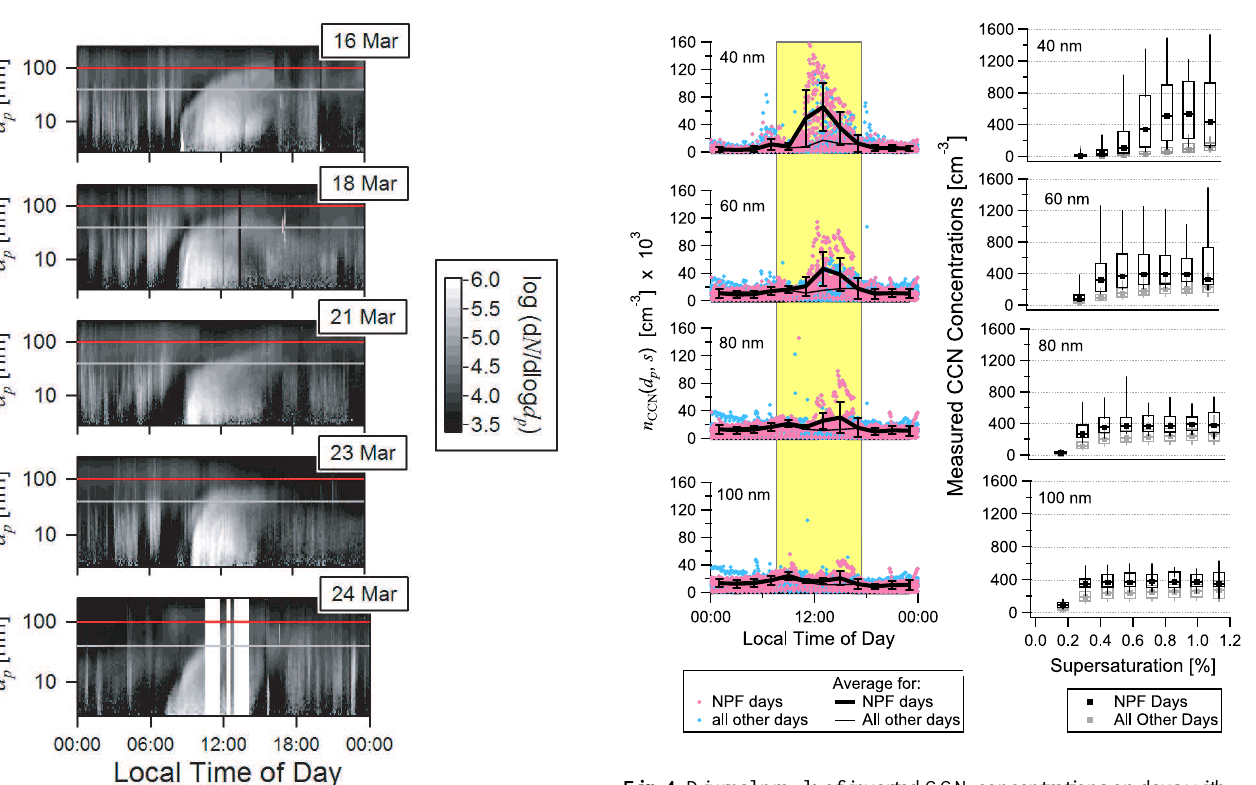
Fig. 4. Diurnal profile of inverted CCN concentrations on days with strong new particle formation (NPF) events, and for all other days, as a function of particle size, with 2 hour average CCN concentrations at s > 0.5% overlaid. Also shown are quartiles of measured CCN concentrations on NPF days and on all other days as a function of the instrument supersaturation and particle size.